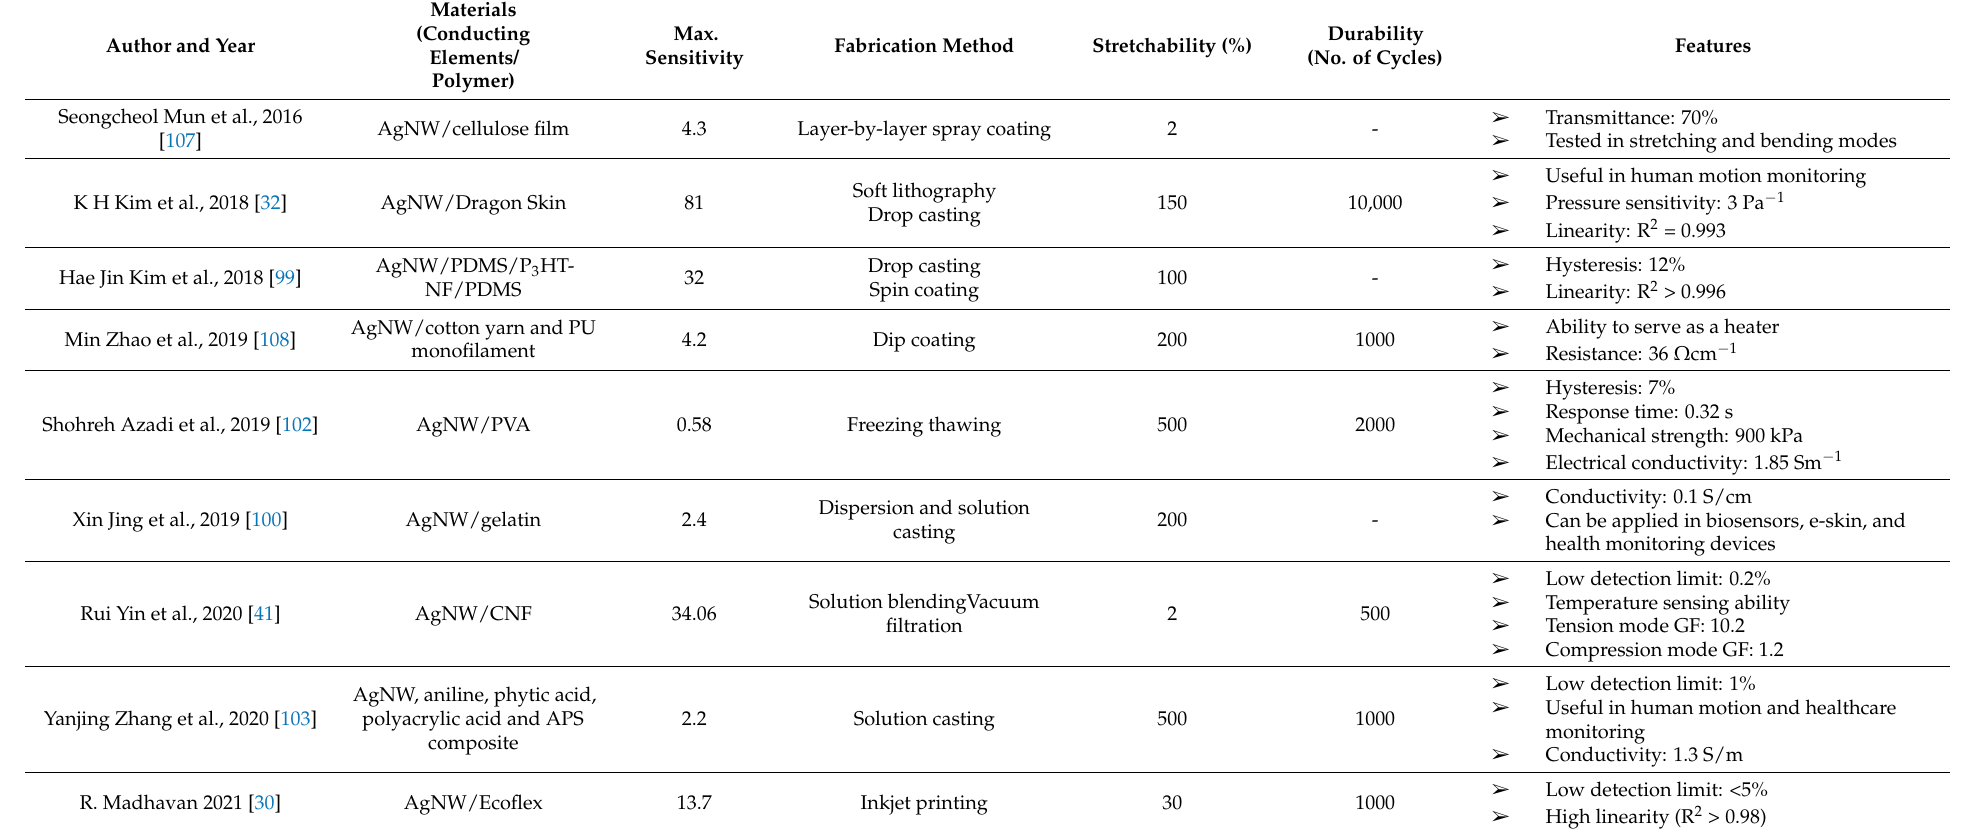
Table 5. Overview of stretchable strain sensors using AgNWs as a single filler in other